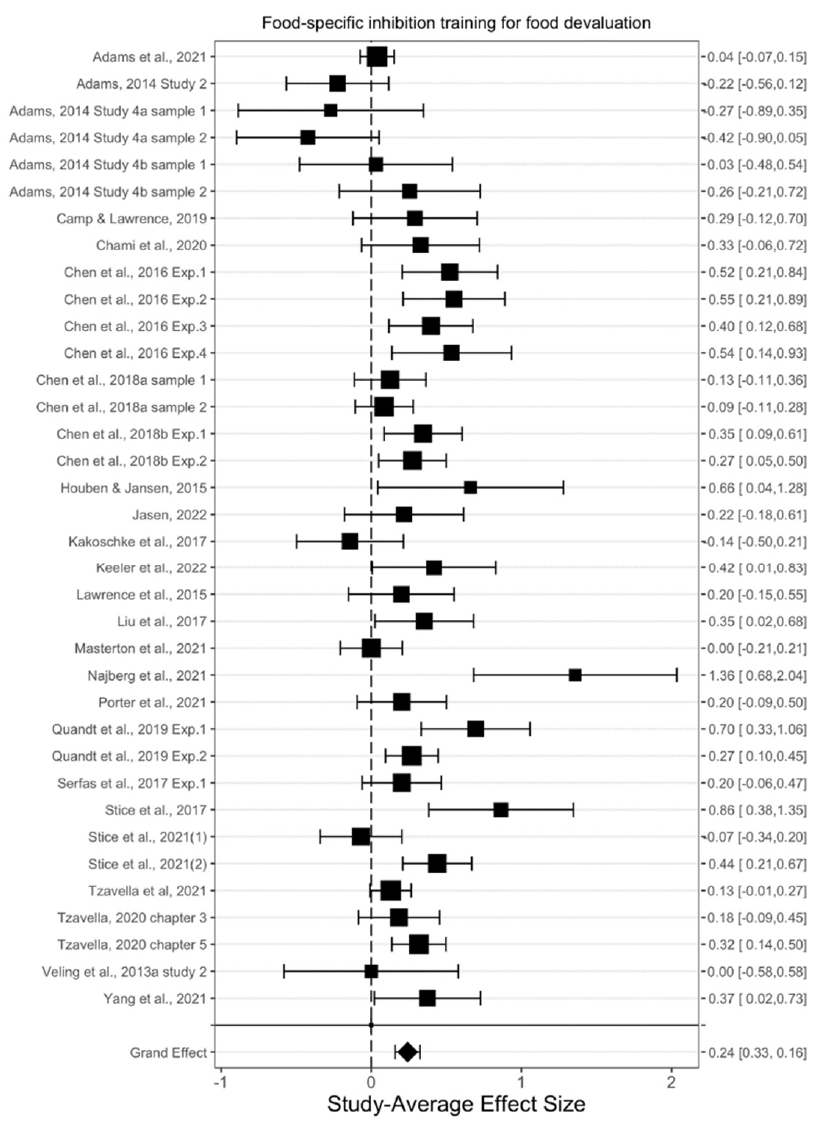
Figure 3. The effects of food-specific inhibition training on food evaluation.